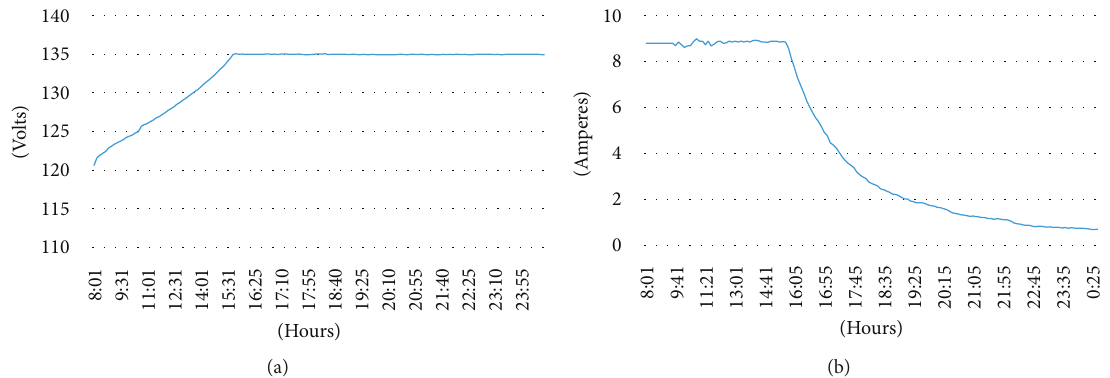
Figure 8: (a) Behavior of the battery bank voltage in charge mode and (b) behavior of the battery bank current in charge mode.